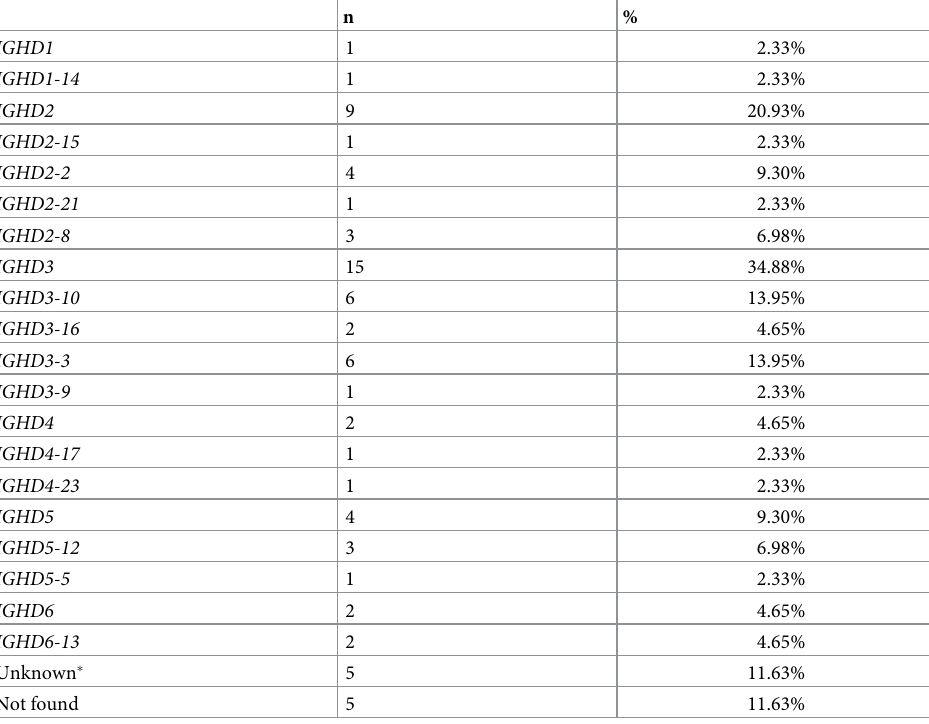
Table 4. The IGHD gene repertoire in 43 IGH rearrangements from 39 samples with clonal IGH rearrangements.